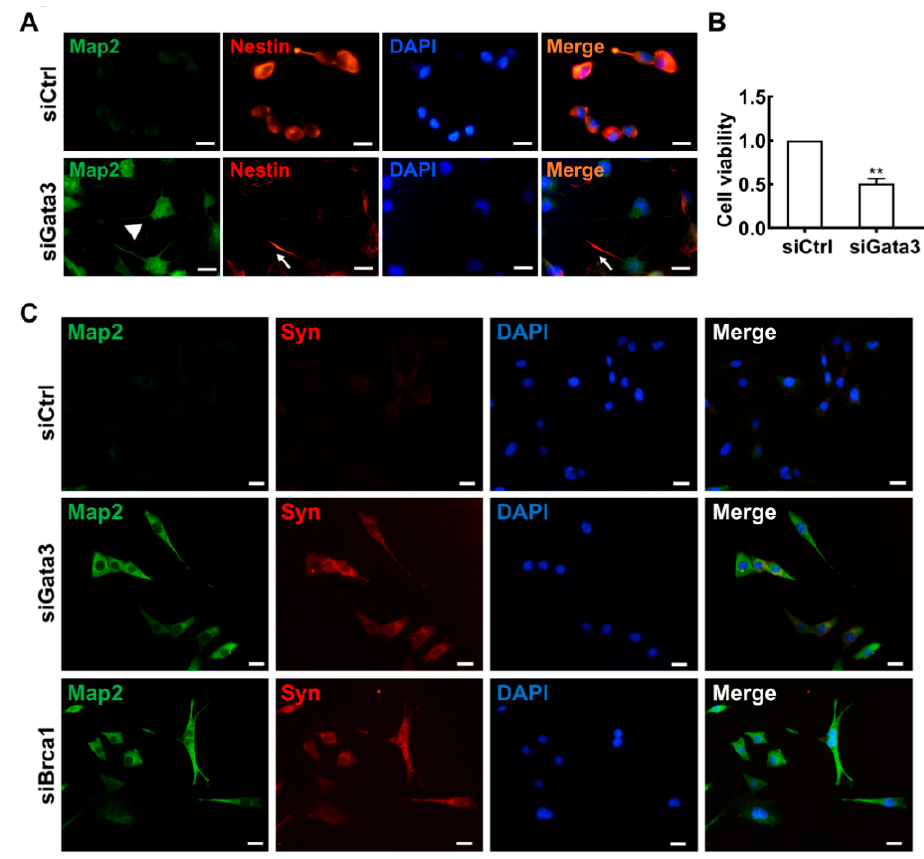
Figure 5. Gata3 inhibition induces cell differentiation in 661W cells. ( A ) Strong Nestin (red) and weak Map2 (green) expression were observed in the 661W cells. In Gata3 -silenced 661W cells, Nestin expression was decreased, and Map2 expression was observed. The white arrow indicates neurite outgrowth stained by Nestin , the white arrowhead indicates neurite outgrowth stained by Map2 . ( B ) Gata3 inhibition decreased the viability of 661W cells. ( C ), Both Gata3 silencing and Brca1 silencing induce synaptophysin (red, cell cytoplasm) expression in 661W cells. Scale bars represent 20 µ m. The asterisks indicate statistically significant differences (** p < 0.01).